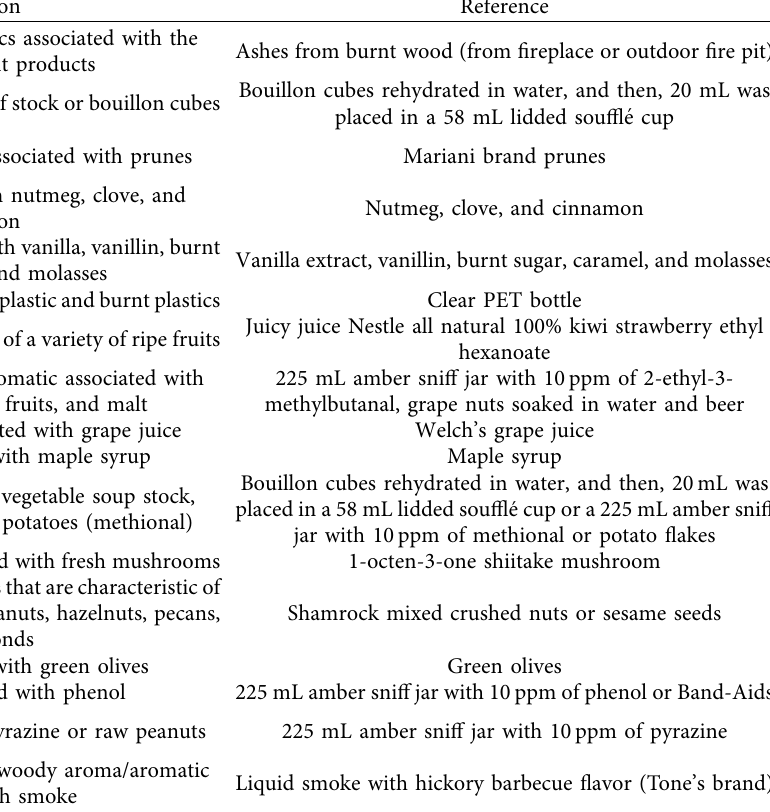
Table 1: Initially trained panel sensory attributes for soy sauce (terms adopted from previous studies are